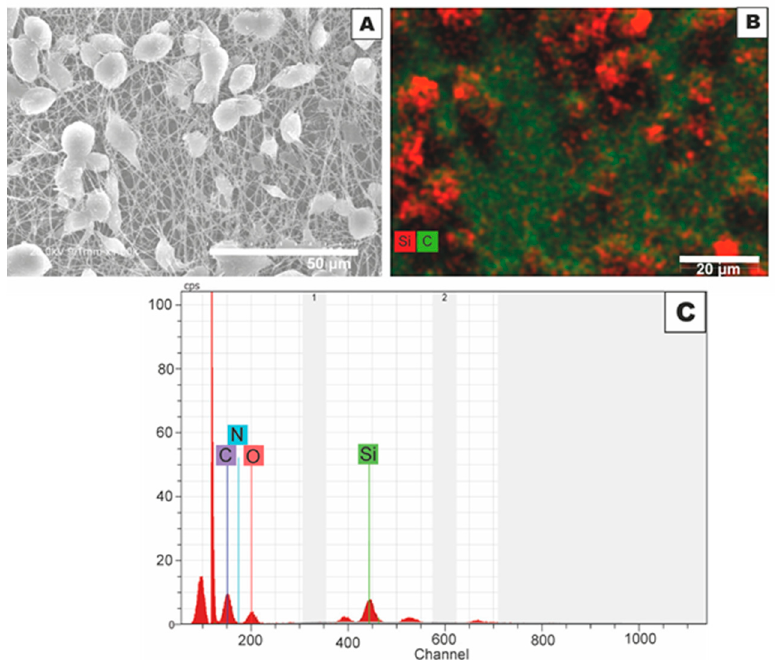
Figure 5. ( A ) Field emission scanning electron microscope (FESEM) micrographs showing a top-view image of the electrospun ultrathin poly( ε -caprolactone) (PCL) fibers coated with electrosprayed silica (SiO 2 ) microparticles; ( B ) FESEM micrographs reported in ( A ) but processed by energy-dispersive X- ray spectroscopy (EDS); ( C ) EDS microanalysis spectrum.